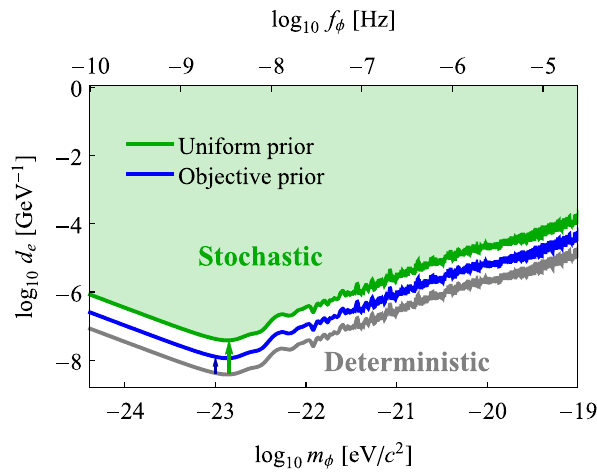
Fig. 3 The modi fi ed constraint, green and blue lines, based on the stochastic approach compared to previous laboratory constraints, gray line, based on the deterministic approach for the dilaton coupling strength d e 41, 46 – 48 . The green and blue lines illustrate the importance of the choice of prior for a Bayesian approach. Supplementary Fig. 3 provides a detailed exclusion